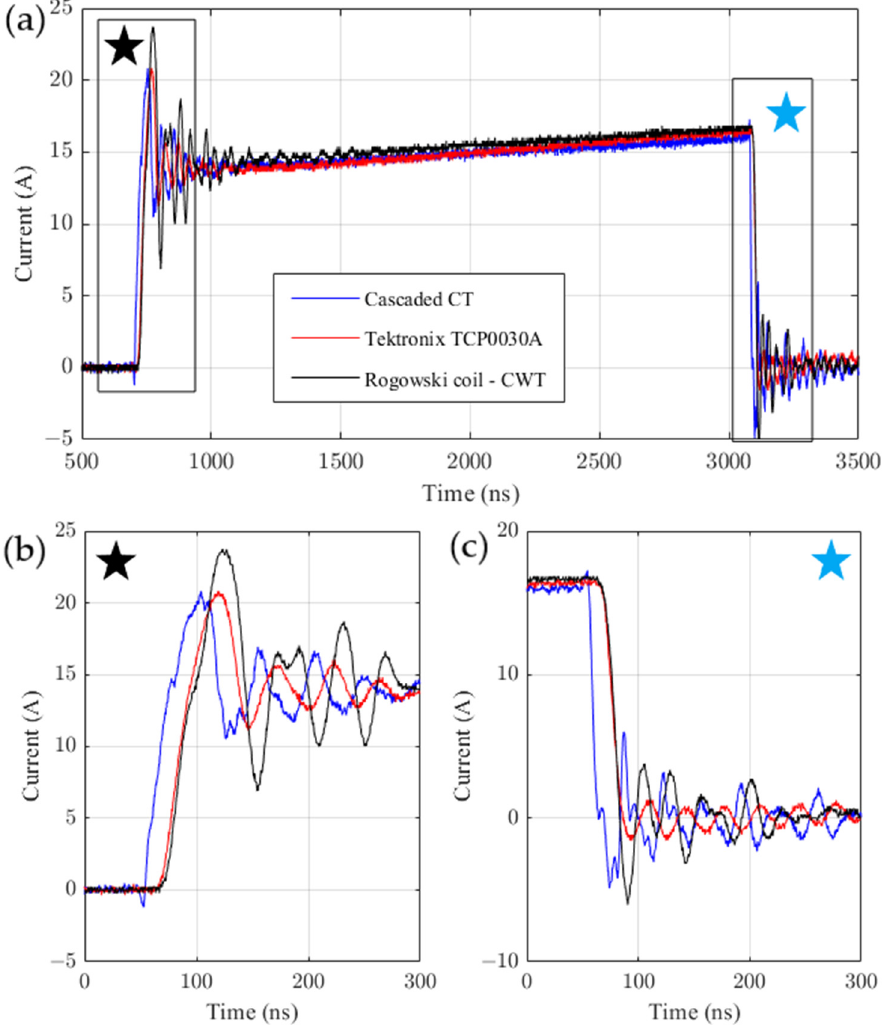
Figure 10. Response of the sensors for current pulse–transient response ( a ) of the transistor turn on ( b ) and turn off ( c ).